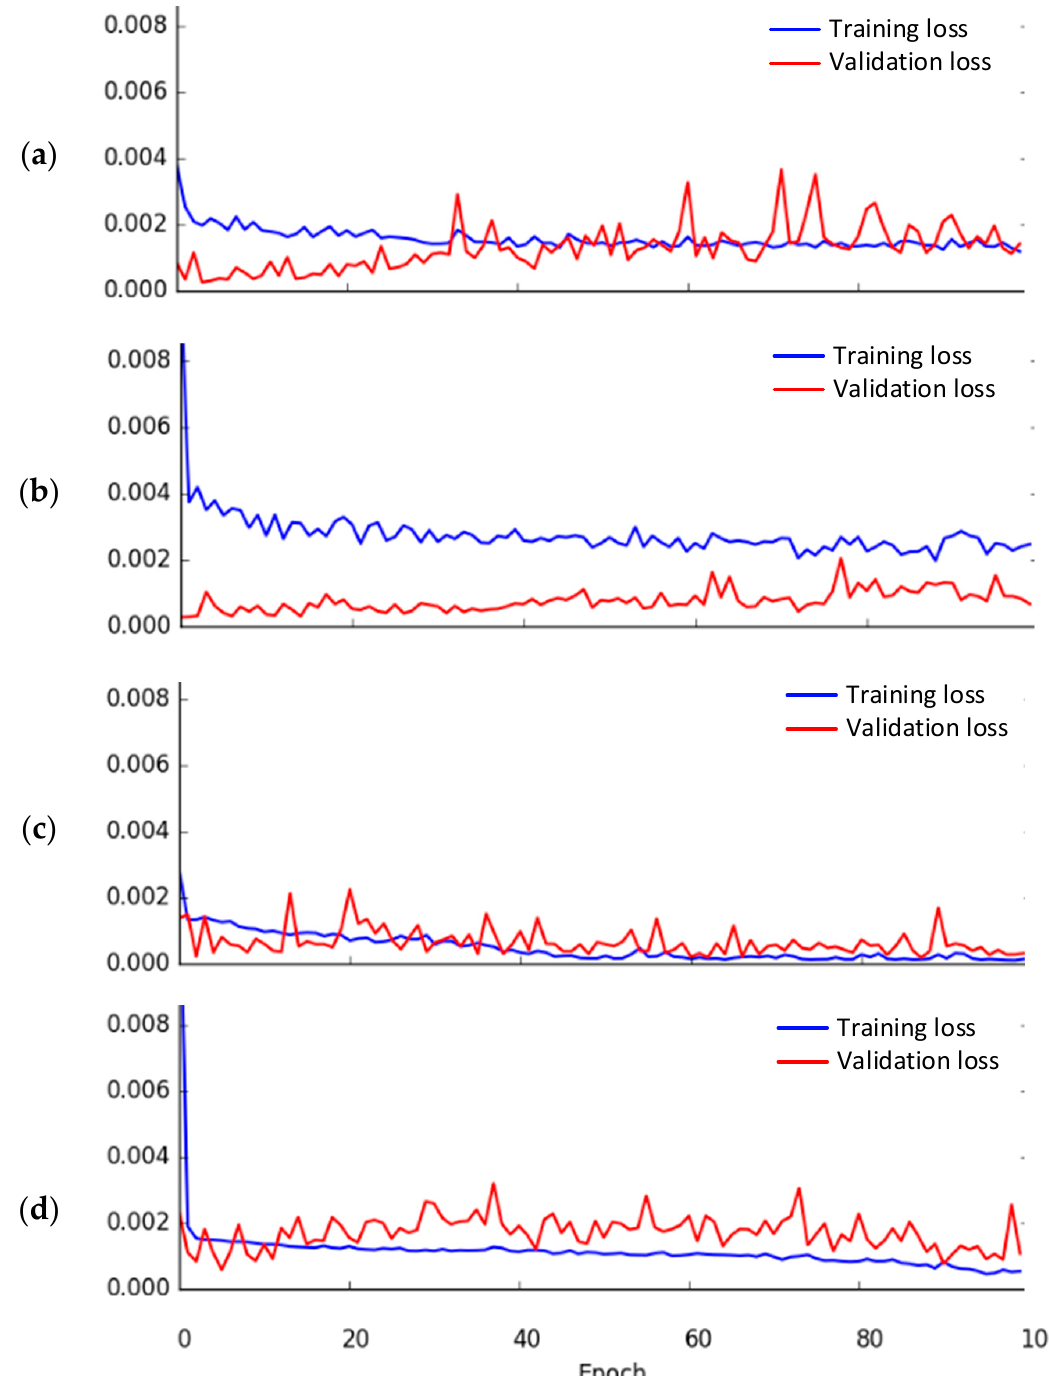
Figure 13. The model loss of RSRP after 10 s of prediction: ( a ) MLP, ( b ) CNN, ( c ) RNN, ( d ) LSTM.